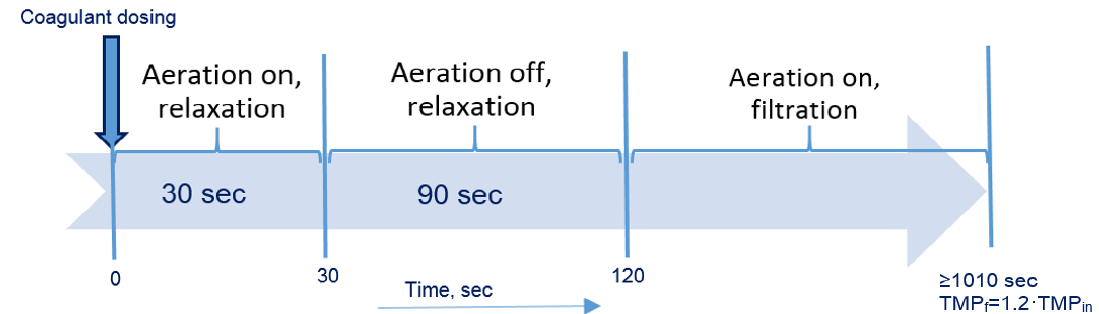
Figure 2. Experimental conditions of the total recycle test.